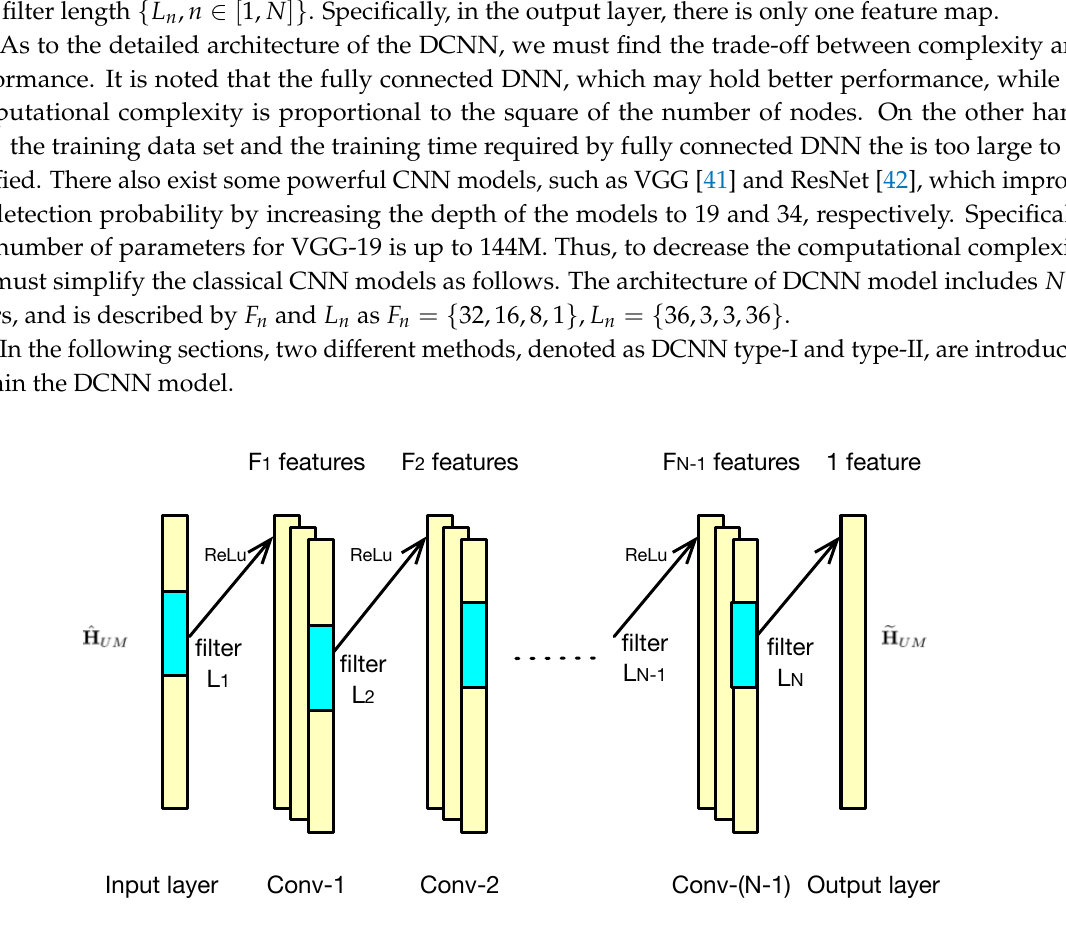
Figure 2. Details of DCNN